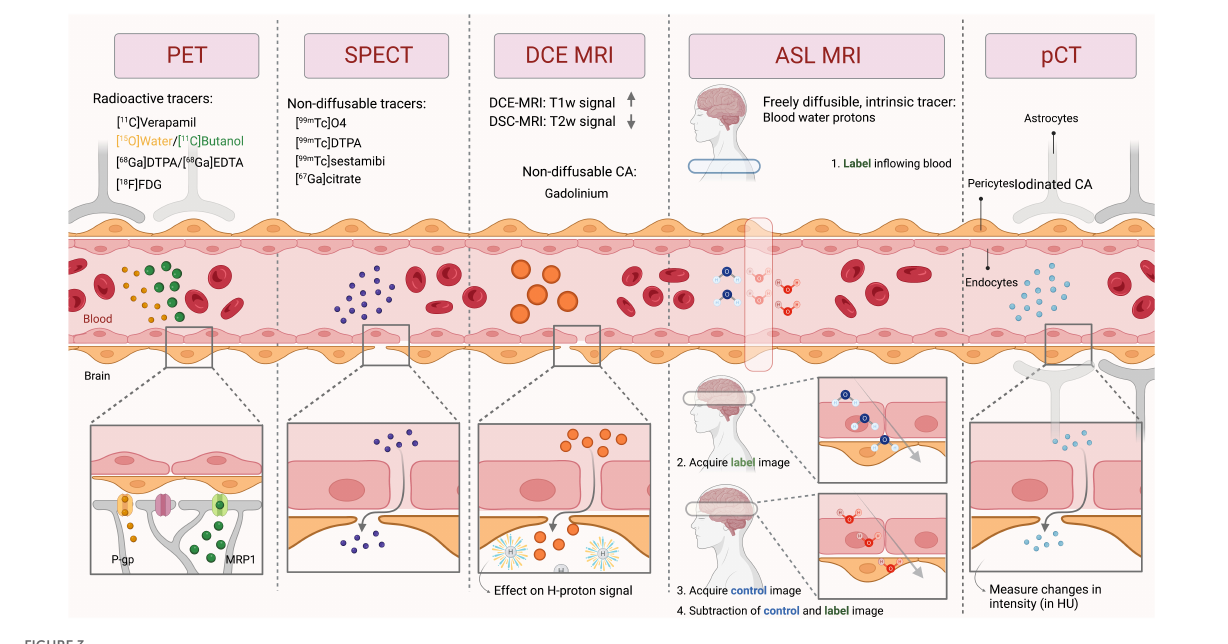
FIGURE3 General principle of the imaging techniques used to measure BBB integrity. PET, Positron emission tomography; SPECT, Single-photon emission computerized tomography; DCE MRI, Dynamic contrast-enhanced magnetic resonance imaging; ASL MRI, arterial spin labeling MRI; pCT, perfusion computed tomography; CA, contrast agent; HU, hounsfield units; P-gp, P-glycoprotein; MRP1, multidrug resistance-associated protein 1; T1w, T1-weighted; T2w,